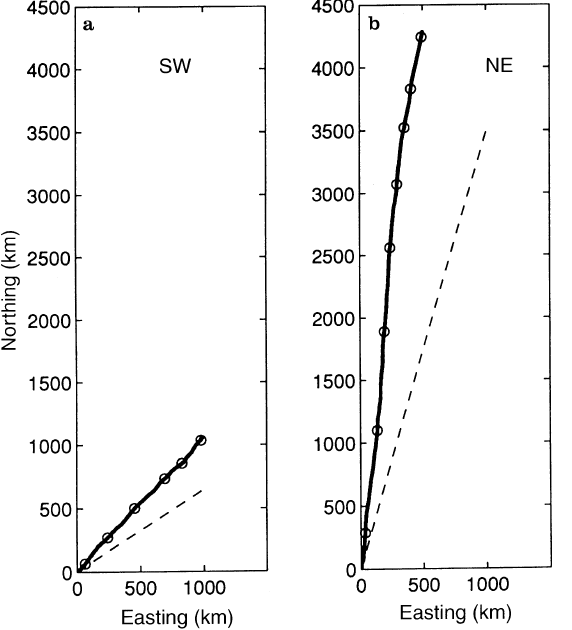
Fig. 5a, b. Progressive vector diagrams for a SW and b NE current meters. Data are filtered with a cut-o(cid:128) frequency of 0.67 cpd and sub- sampled every 6 h. Open circles represent the first of each month, starting from May, and the dashed line indicates the orientation of the shelf edge